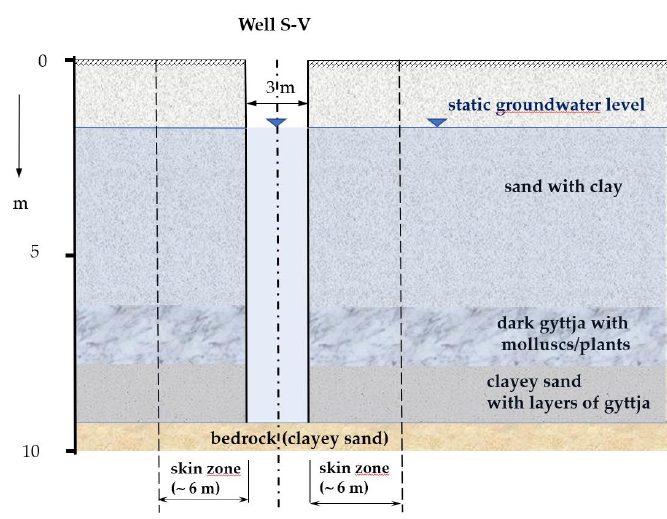
Figure 10. Cross-section of the S-V well with geology [61].